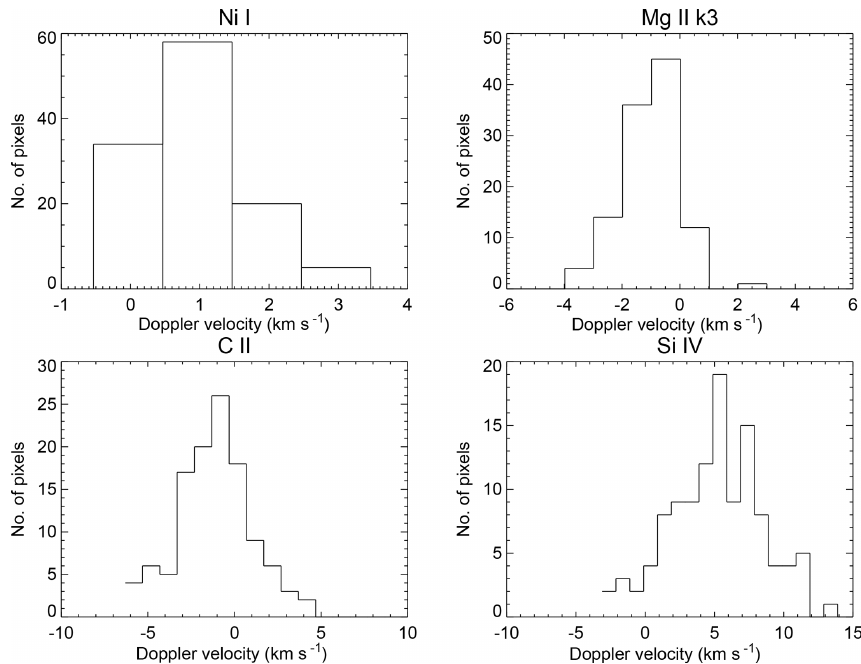
Figure 8. The velocity distributions for different spectral lines corresponding to different temperatures at box